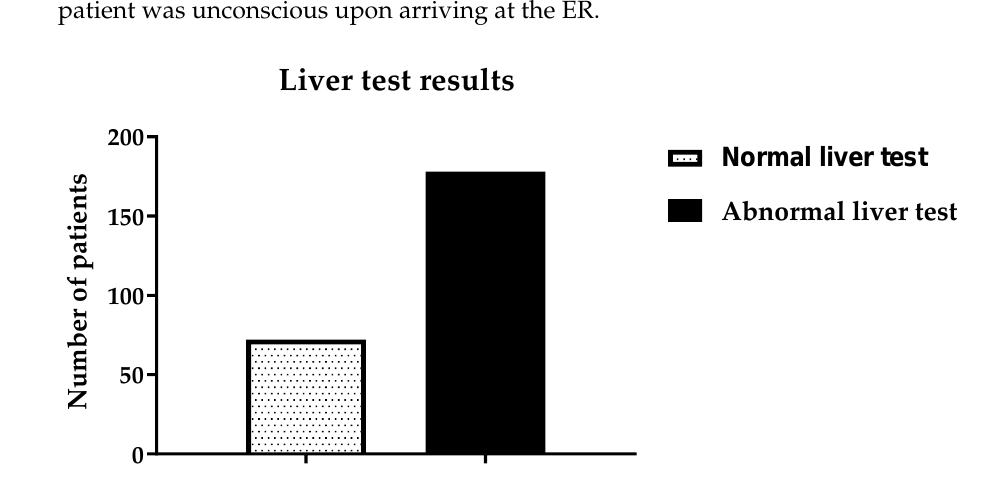
Figure 2. The liver function test results of all the participants.